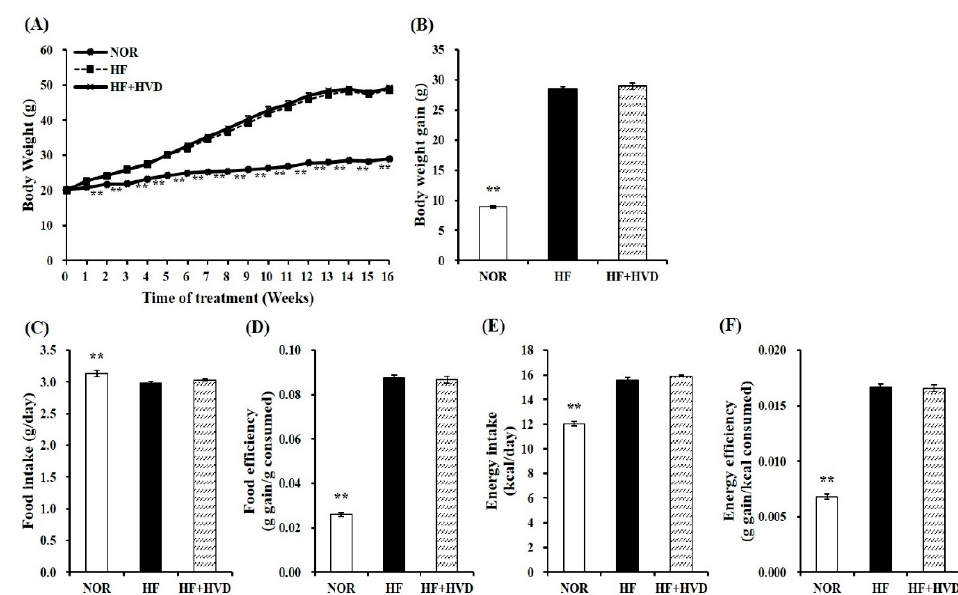
Figure 1. Effect of vitamin D supplementation on body weight and food intake. ( A ) Changes of body weight (g) during 16-week diet supplementation, ( B ) body weight gain (g), ( C ) food intake (g con- sumed/day), ( D ) food efficiency (g gain/g consumed) = body weight gain (g)/total food consumption (g), ( E ) energy intake (kcal/day), and ( F ) energy efficiency (g gain/kcal consumed) = body weight gain (g)/total energy intake (kcal). Values are expressed as the mean ± SEM ( n = 9/group). NOR, 10% fat diet with 1000 IU vitamin D; HF, 60% fat diet with 1000 IU vitamin D; HF + HVD, 60% fat diet with 10,000 IU vitamin D. ** p < 0.01 compared to the HF group.